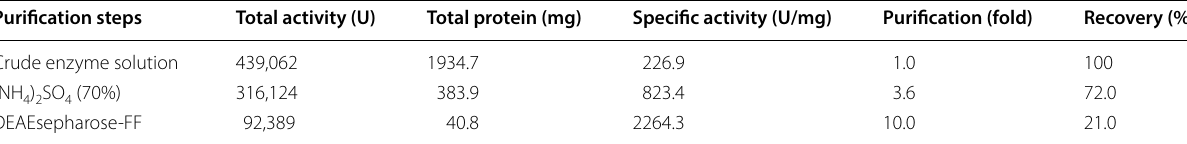
Table 1 Purification steps of neutral protease from Aspergillus oryzae Y1 Purification